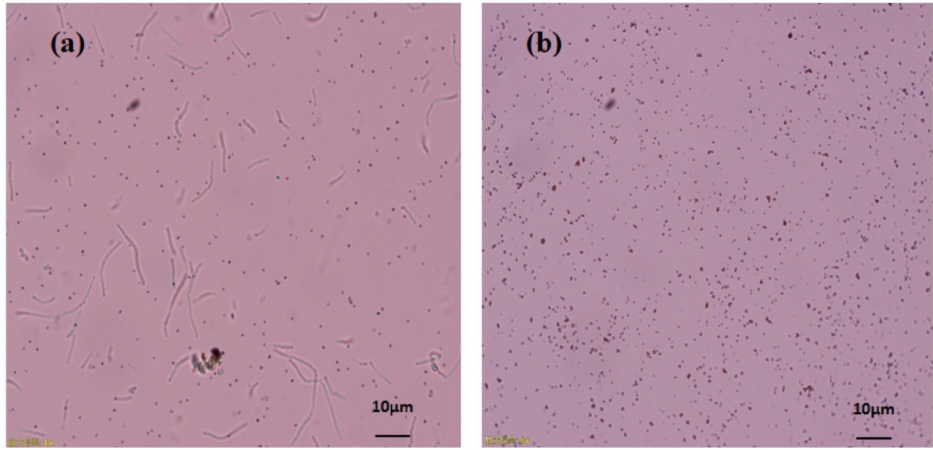
Figure 3. Microscopic image of extracellular SeNPs, before purification ( a ), after purification ( b